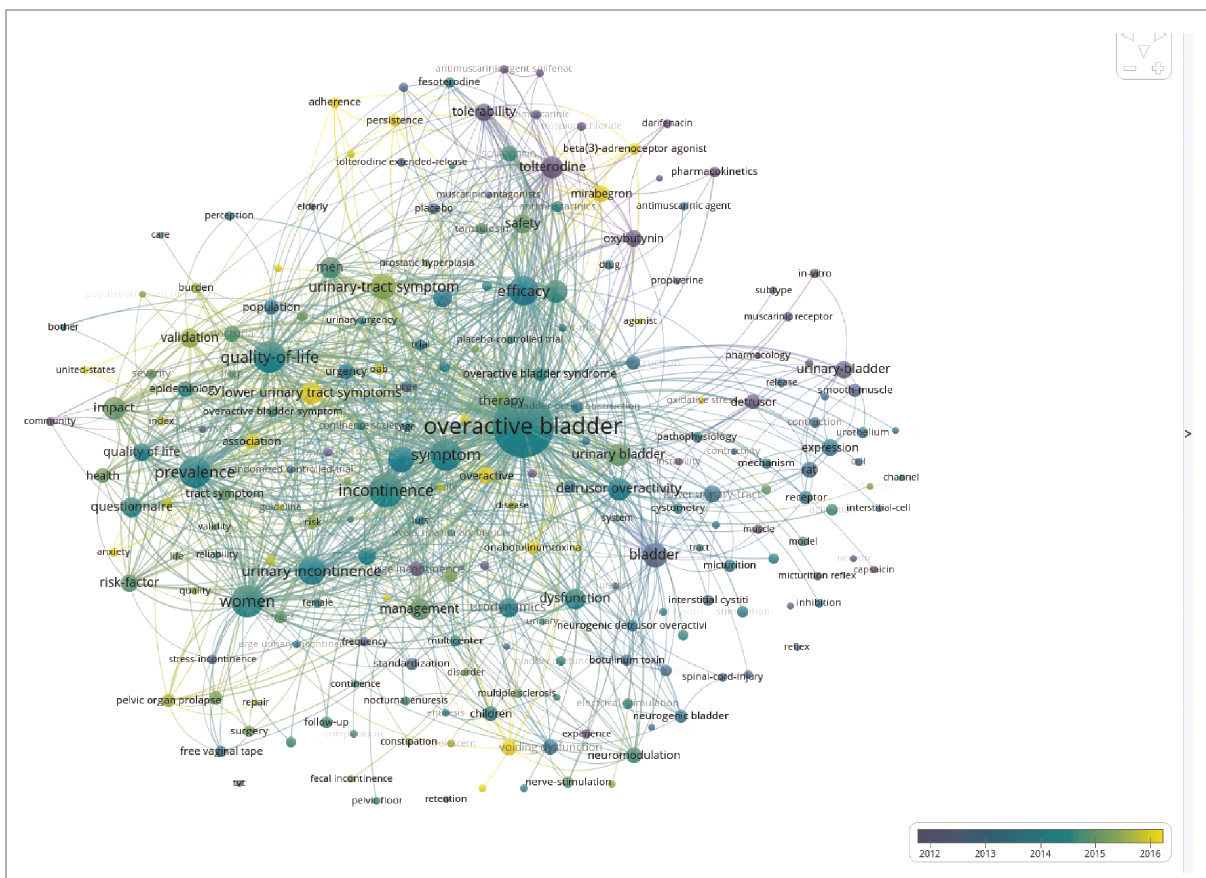
FIGURE 7 Co-occurrence analysis of all keywords in the publications onOveractive bladder: mapping of the keywords in the fi eld of overactive bladder. Distribution of keywords according to the average time of appearance; blue represents an early appearance, and yellow represents a late